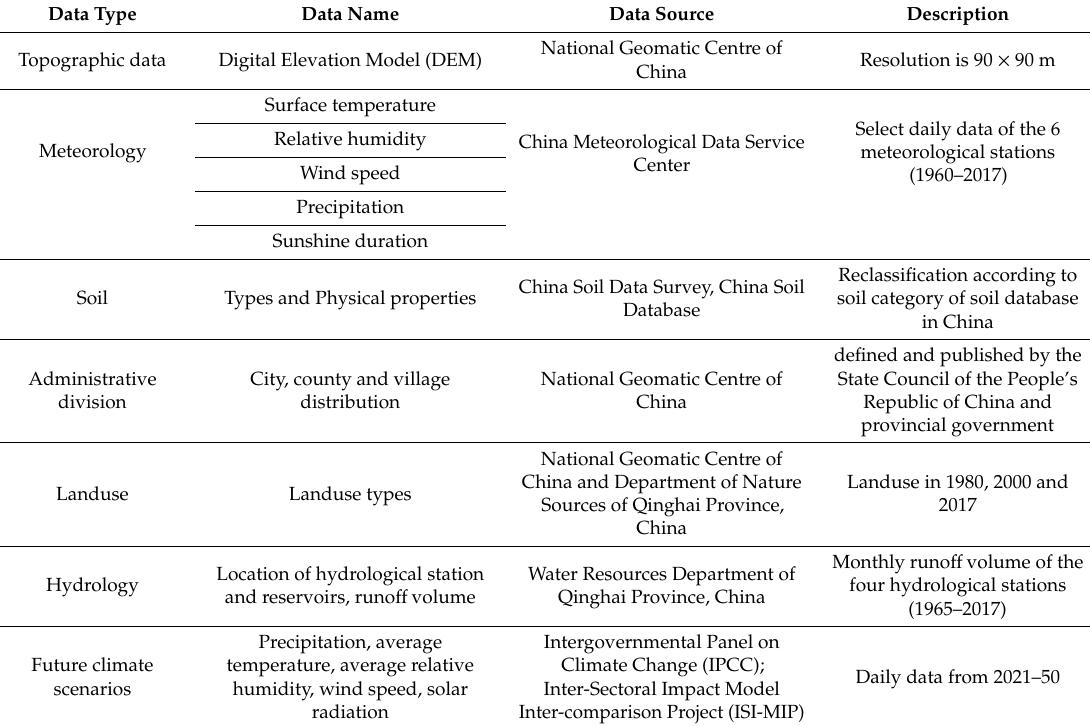
Table 2. Data types, sources and description.